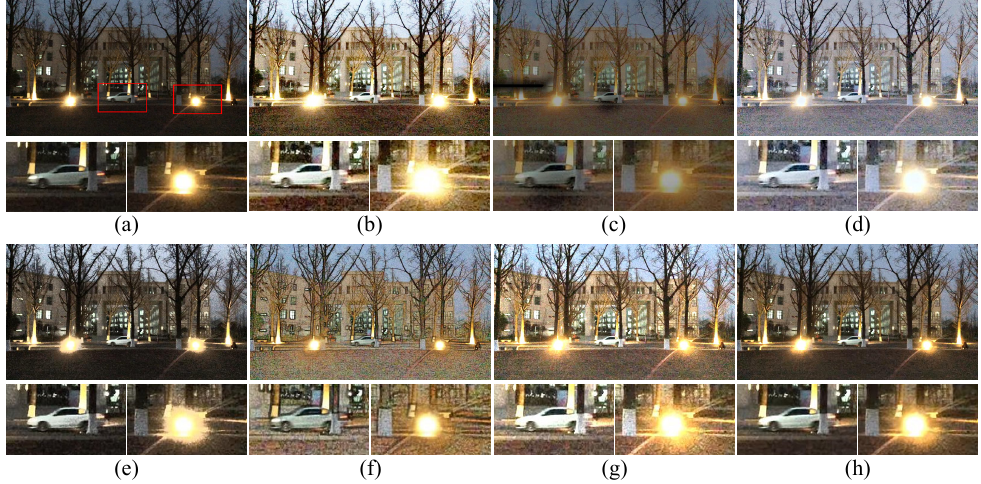
Figure 11. Visual comparison between enhancement results in a noisy low-light image. ( a ) Input, ( b ) HE [33], ( c ) SSR [18], ( d ) MSRCR [34], ( e ) CVC [35], ( f ) Dong [36], ( g ) LIME [28], ( h ) ours.